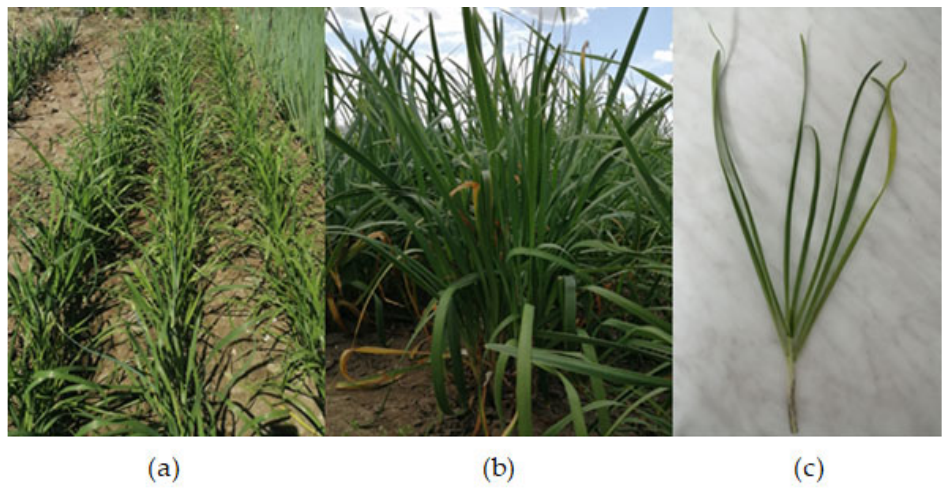
Figure 3. Appearance of A. odorum ( a , b ); edible parts (leaves) of A. odorum ( c ).